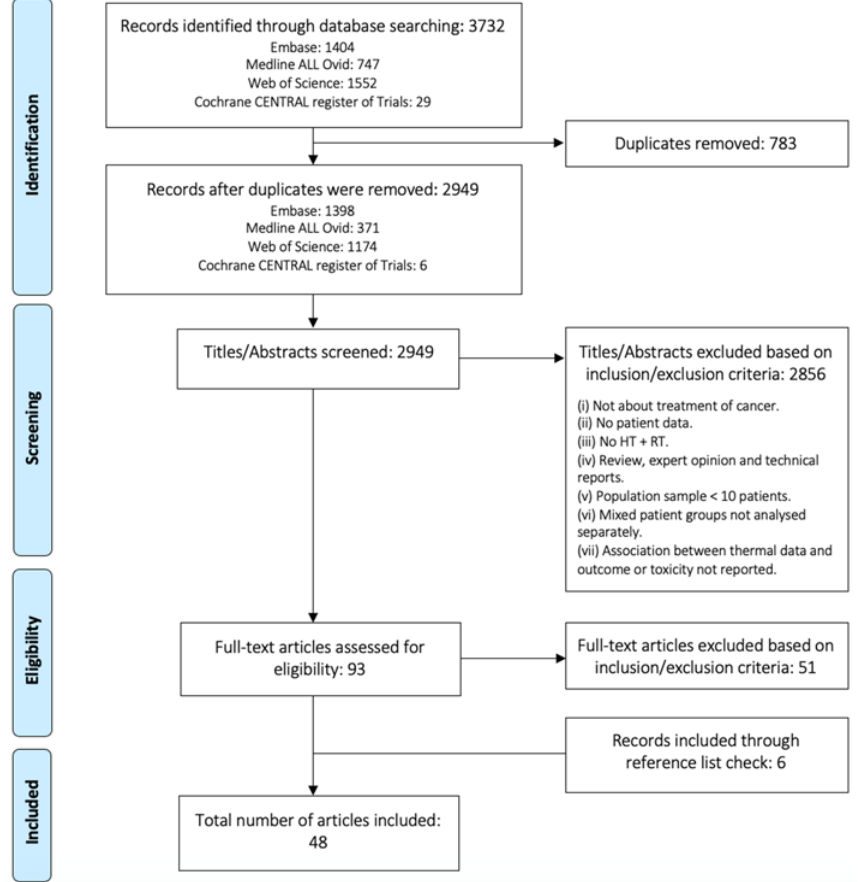
Figure 1. Flow chart indicating the study selection procedure according to PRISMA statement [28].